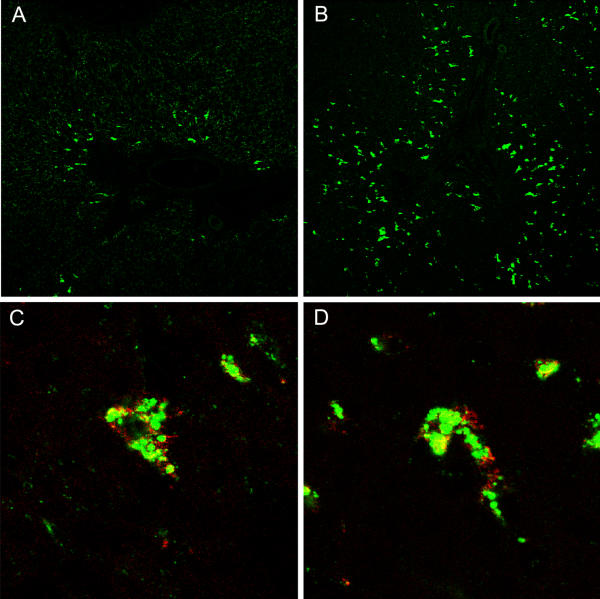
Distribution of injected, inactive bovine LPL in livers, and the effect of heparin All sections are 15 min after injection of inactive bovine LPL. The sections in panels A and C are from rats that did not receive heparin; the sections in panel B and D are from rats that had been given heparin five min before the lipase. Green colour represents staining of LPL by the rabbit polyclonal antibody. Red colour represents staining of Kupffer cells by the ED2 antibody. Panels C and D show both stainings. The magnification was × 20 in panels A and B; × 60 + zooming in panels C and D.